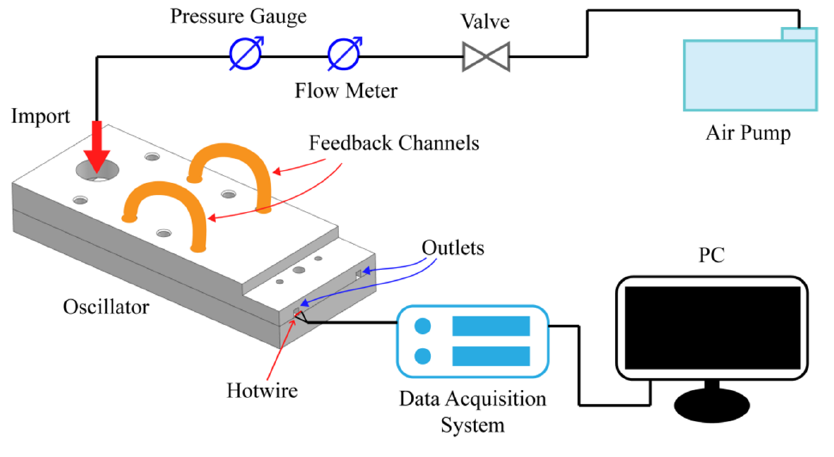
Figure 4. The oscillator test